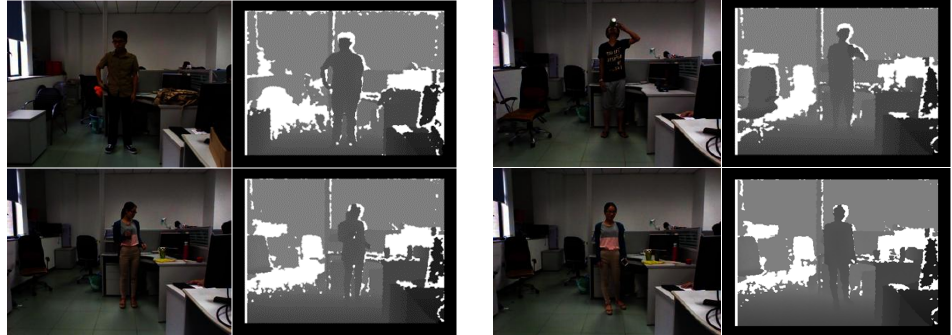
Figure 1. The existing RGB-D datasets focused on human